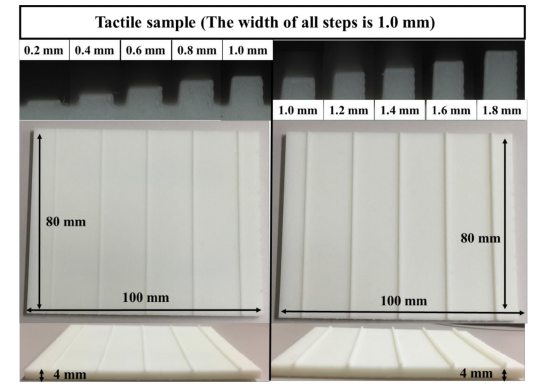
Figure 7. Photograph of the tactile